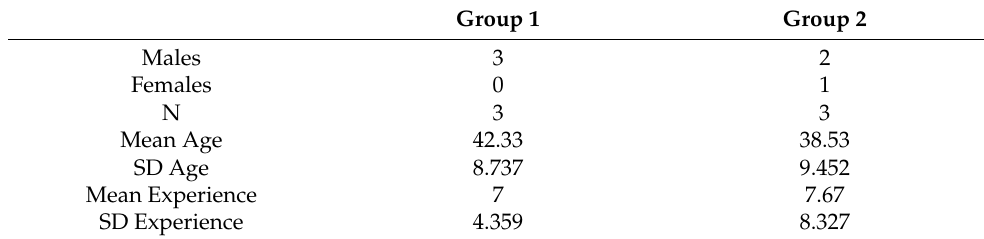
Table 4. Participants Demographic Information .